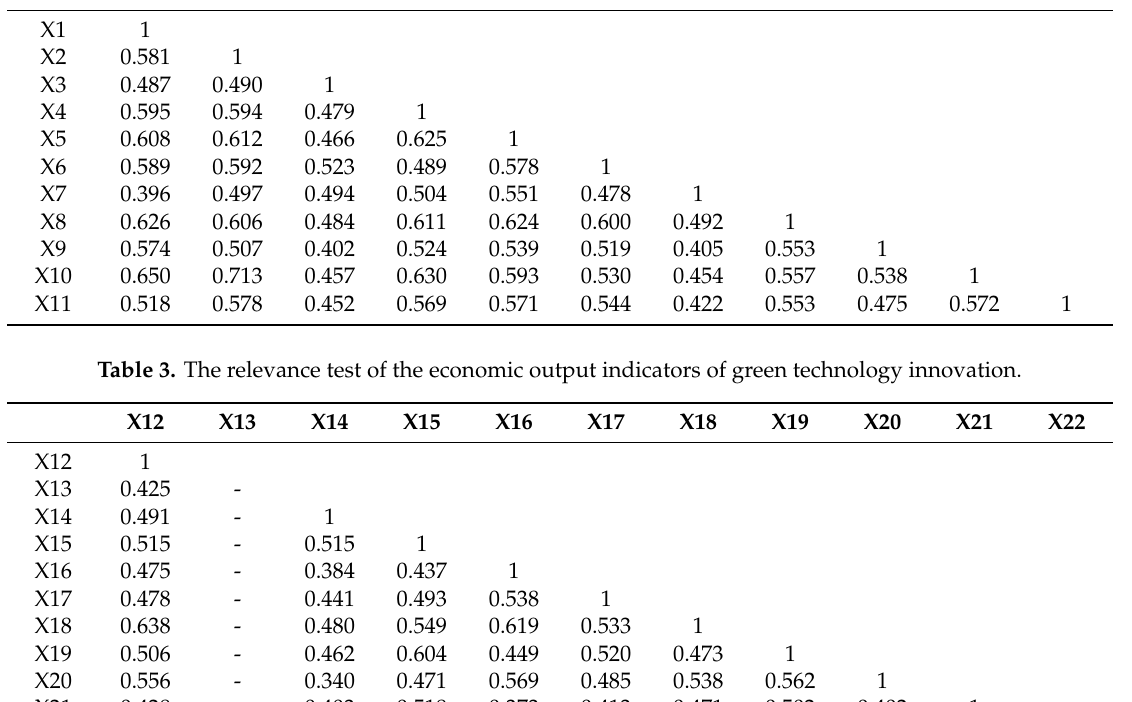
Table 2. The relevance test of the technology output indicators of green technology innovation. X1 X2 X3